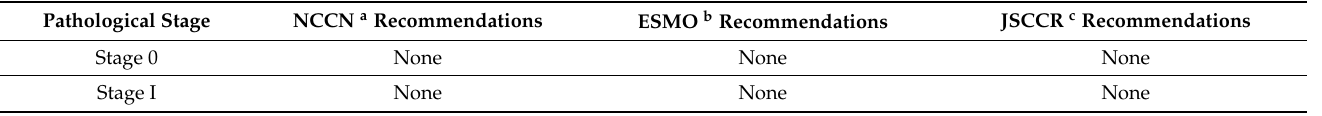
Table 3. Colon cancer: Adjuvant